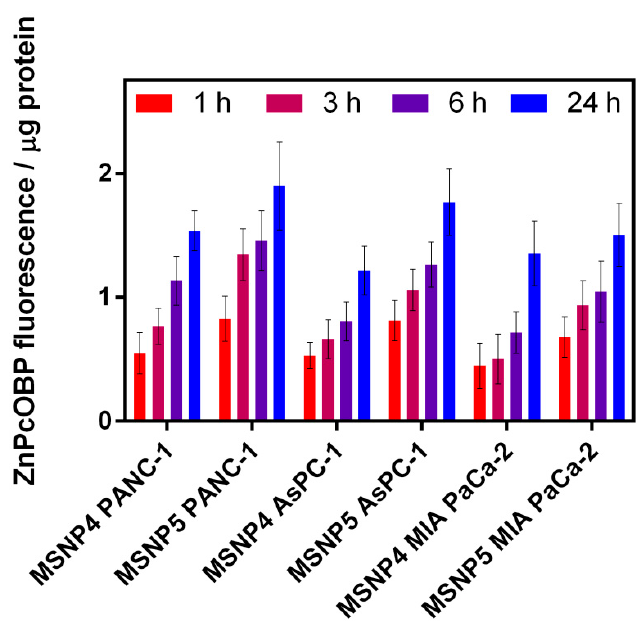
Figure 4. Cellular uptake kinetics of MSNP4 and MSNP5 nanoparticles on PANC-1, AsPC-1 and MIA PaCa-2 cells.